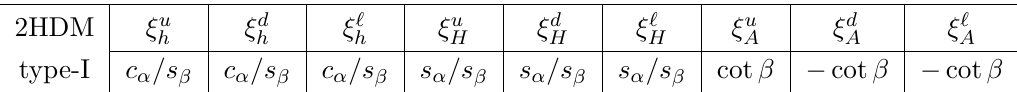
table 1. Note that we can write couling of H with fermions ( s